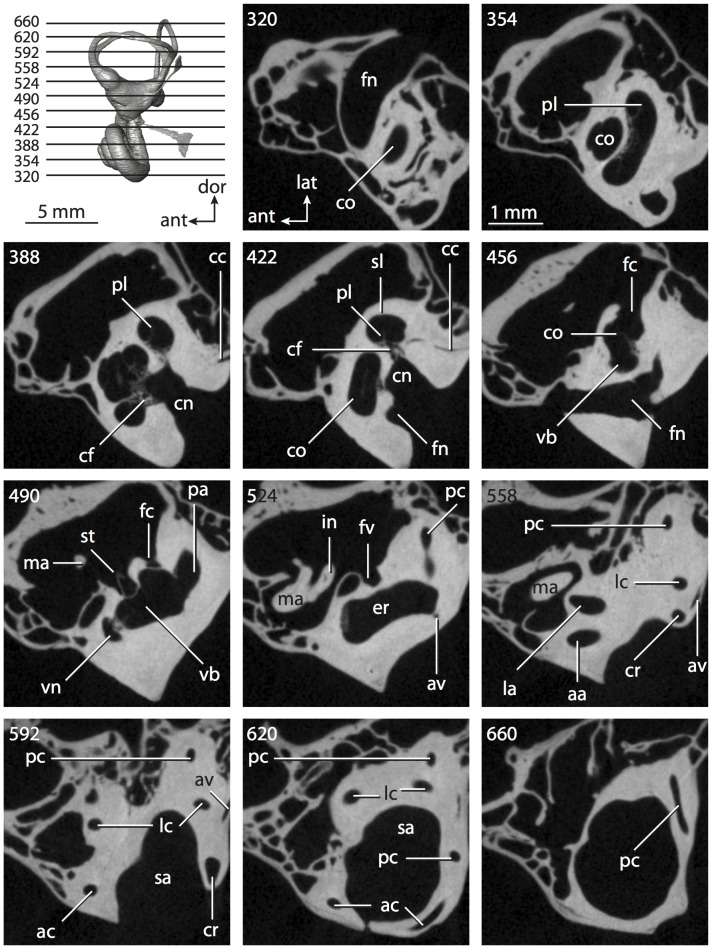
CT slices through ear region ofMacaca mulatta.Abbreviations listed at the end of the Materials and Methods section.